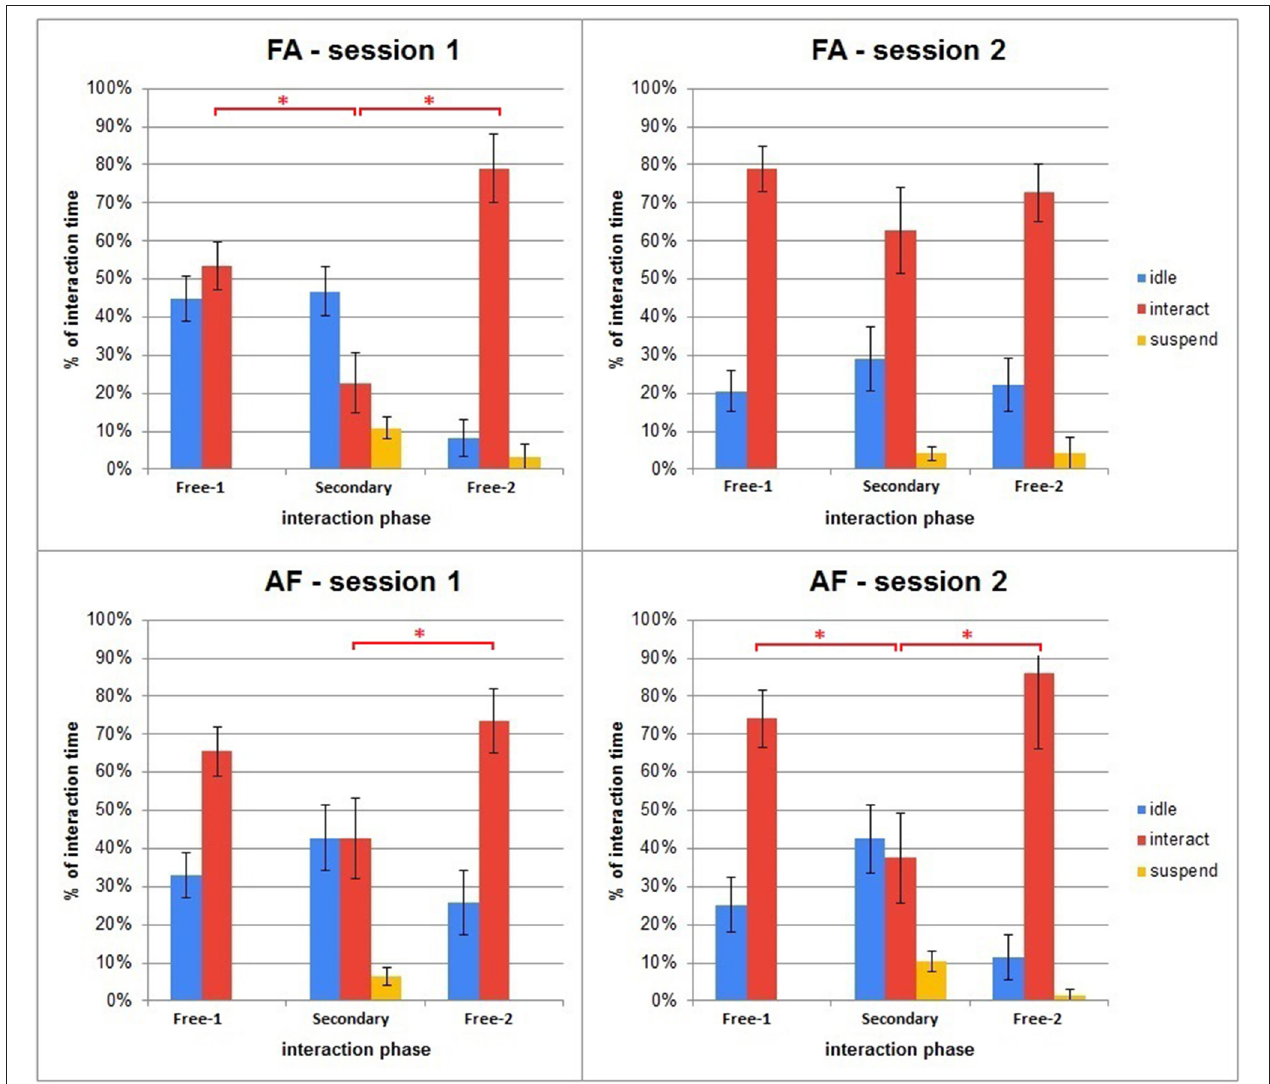
FIGURE 10 | Average percent of interaction times spent in the major states, shown across phases and sessions. Error bars represent standard error. Asterisks indicate significant